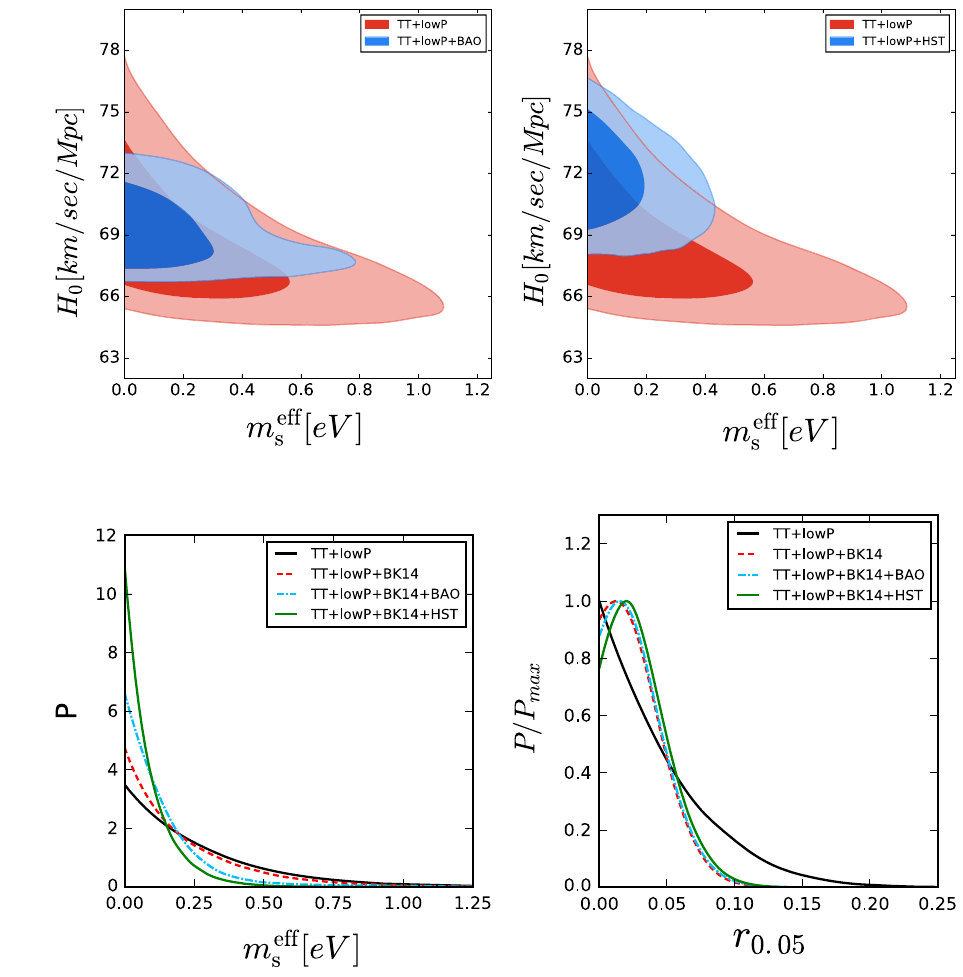
+ N + m eff eff 0 . 05 s